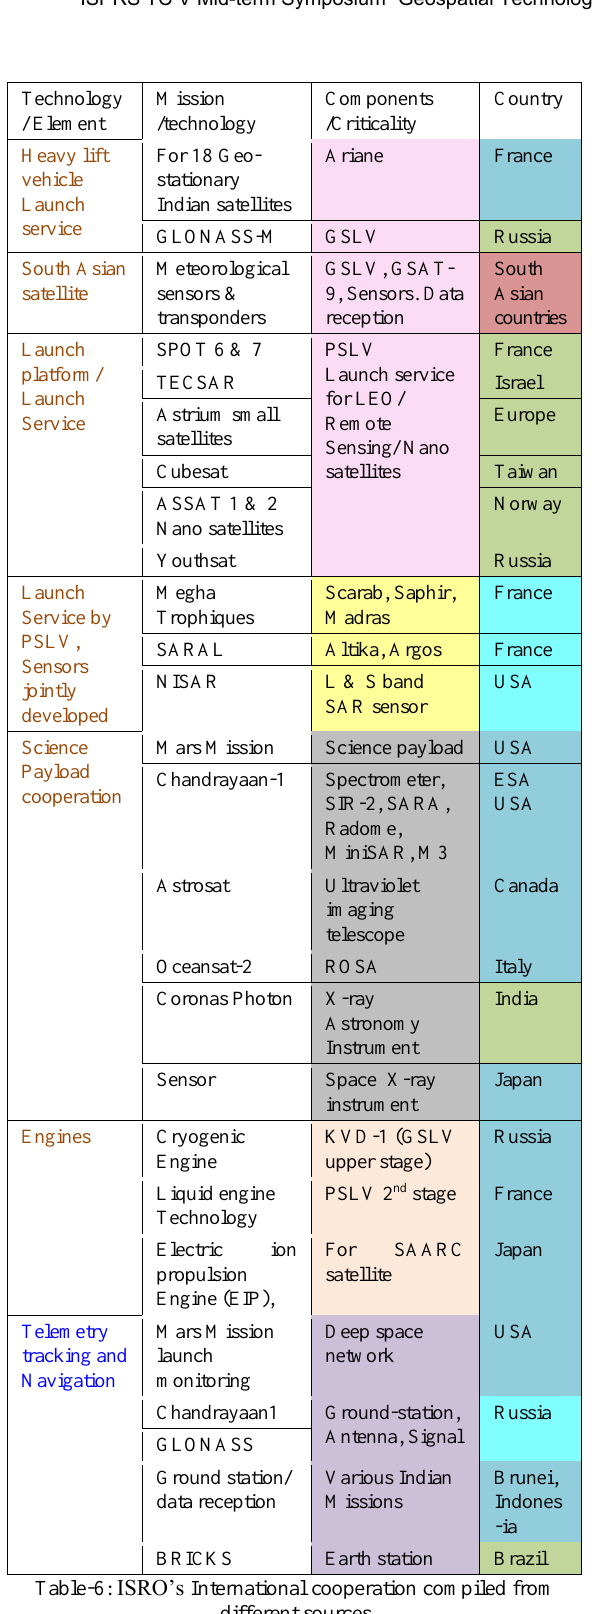
Table-6: ISRO’s International cooperation compiled from different sources Green color indicated technology/ services are provided by ISRO; Blue color indicated that ISRO received cooperation from international agencies/ communities; Light Pink color indicate launch vehicle (short term cooperation); Orange color indicate technical co-operation; Violet color indicate ground segment service linked with infrastructure and/ or technological expertise; Grey color indicate scientific cooperation and